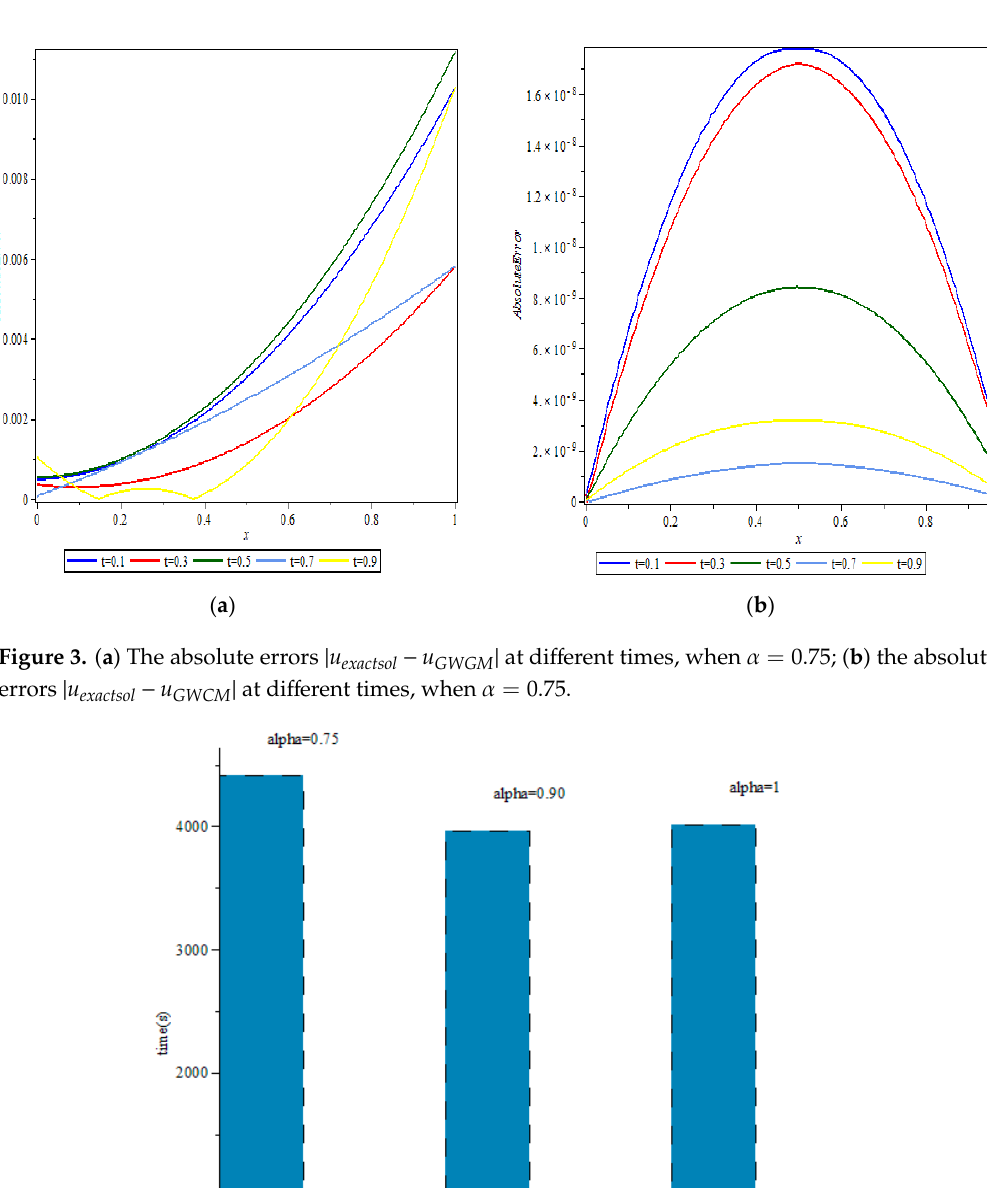
Figure 2. ( a ) The absolute errors